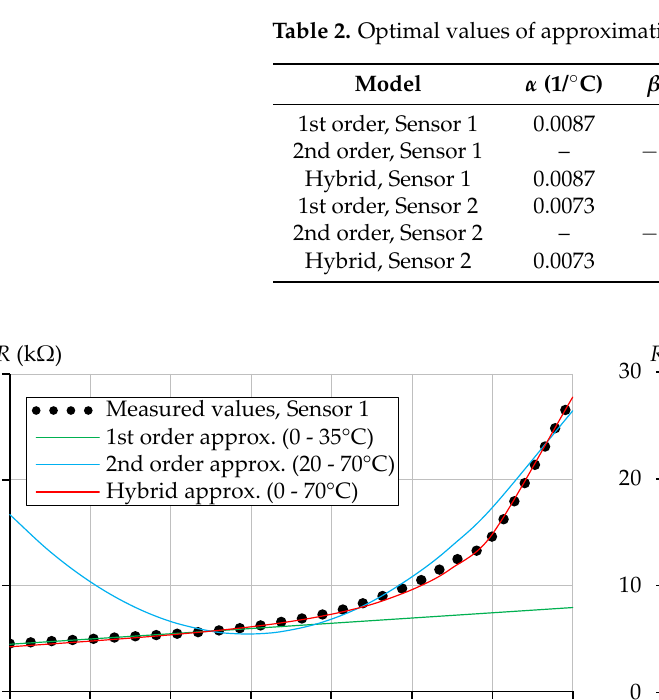
Table 2. Optimal values of approximation coefficients and corresponding RMSD of three models.